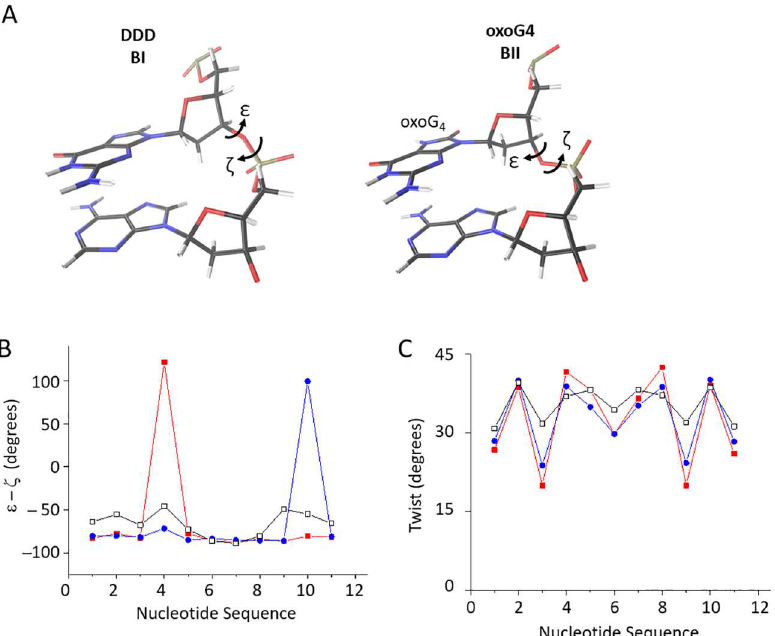
Fig 4. Results from the NMR-driven restrained molecular dynamics simulation of oxoG4 and oxoG10. (A) The difference in backboneconformation between BI and BII conformations. ε and ζ are highlighted in accordance to their torsion angle definition, as BI and BII are defined by the ε – ζ . For both DDD BI and oxoG4 BII structures, the G 4 and A 5 are shown and rotated to highlightthe backbonedifferences. The DDD BI conformation (left panel) is from the PDB ID INAJ structure. The BII conformation induced by oxoG4 (right panel) is from our averaged minimized structure, PDB ID 5IV1. Carbons are shown in black, oxygen is shown in red, nitrogen in blue and hydrogensin white. The additional oxygen at C8 and hydrogen at N7 in the oxoG 4 base are color-codedin the same way. (B) The ε – ζ shows BII directly 3’ of the modification site for oxoG4 and oxoG10. BI is defined as ε – ζ less than 20˚, with over 20˚ defined as BII. The nucleotidesequence numbers correspondto the steps in the sequence, with ε – ζ for nucleotidestep 1 corresponding to the torsion angles between C 1 and G 2 in C 1 G 2 C 3 G 4 A 5 A 6 T 7 T 8 C 9 G 10 C 11 G 12 . In black with open square markers, are the ε – ζ for 1NAJ (DDD). In red with closed square markers are ε – ζ for oxoG4 and blue with closed circle markers are oxoG10. (C) oxoG4 and oxoG10 cause significant unwindingnear the modification site. Color schemes and data origins are the same as in panel B.